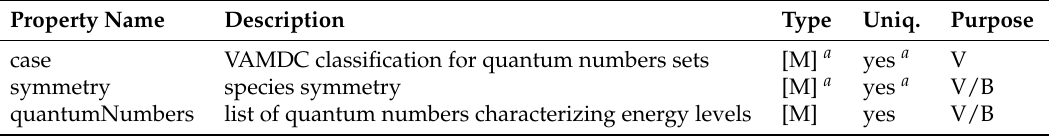
Table 3. List of properties/metadata for “Energy Origin” object tables. “case” refers to the case-by-case document (http://www.vamdc.eu/documents/cbc-1.0/). The symbols [M] and [O] indicate that the metadata are either mandatory or optional in the import file. In the column “Uniq.”, we indicate whether the metadata defines the uniqueness of the object. In the column “Purpose”, we indicate whether the information is meant for the BASECOL (B) public WebUI display and/or for VAMDC (V) interoperability.